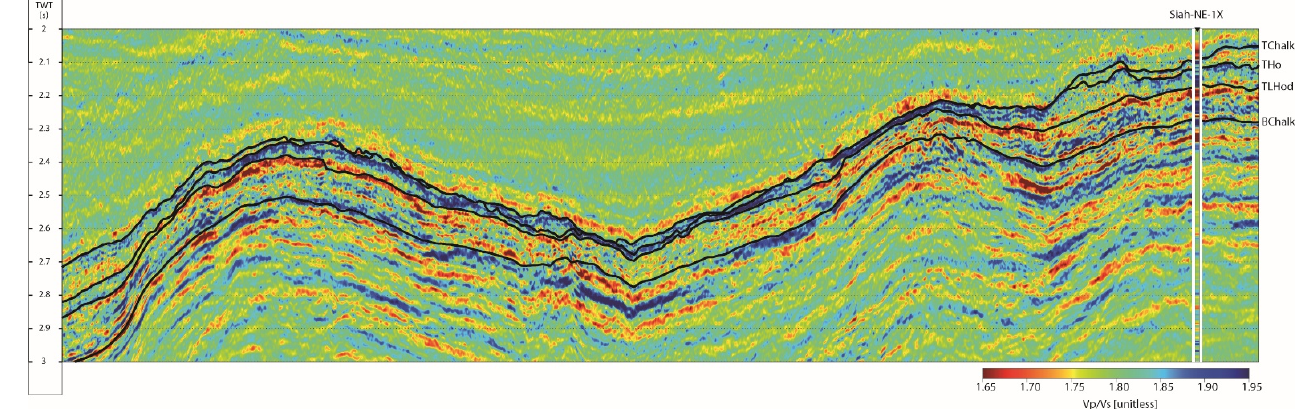
Figure 15. Deterministic inversion result—Vp/Vs ratio from a composite seismic line. Well trajectories intersected by the composite line are plotted with Vp/Vs log data where available. The four seismic surfaces used are plotted in black.